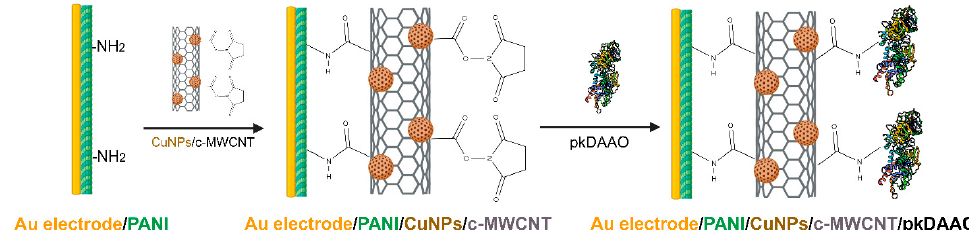
ff s. At first, multiwall carbon